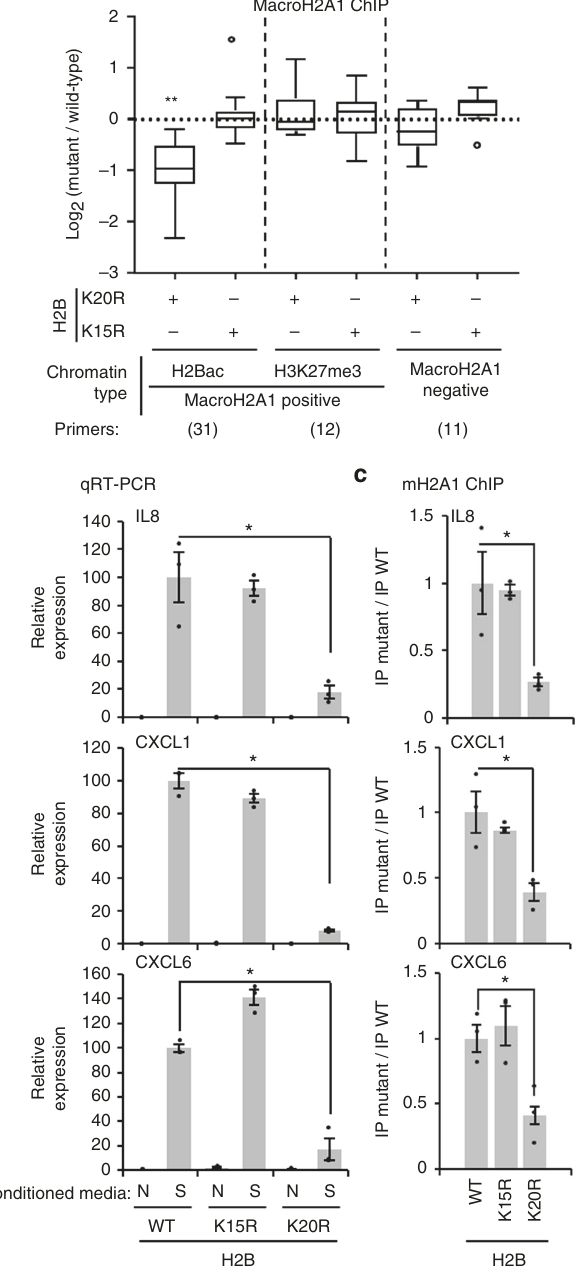
Fig. 5 H2BK20ac promotes macroH2A1 deposition into H2B-acetylated chromatin. a Endogenous macroH2A1 ChIP-qPCR from cells expressing H2B constructs described in Fig. 3b using primers targeting locations within the indicated types of chromatin (regions containing either H3K27me3 or H2B-acetylated chromatin that are associated with macroH2A1 or lack macroH2A1). Data is displayed as a ratio of mutant H2B to wild-type H2B. Center line is the mean and bounds are 95% con fi dence interval of the mean. (* p = 1.6 × 10 − 11 ). b RT-qPCR for the indicated SASP genes from cells described in Fig. 3b that were subjected to paracrine senescence with conditioned media from H-Ras V12 -mediated oncogene induced senescent cells (S) or with cultured media from normal cells (N) as a control. (* p < 0.02). c Endogenous macroH2A1 ChIP-qPCR for SASP genes shown in b . Bars represent the ratio of macroH2A1 association in mutant to wild-type H2B. ( p < 0.03). Error bars, s.e.m., n = 3 independent cell passages, p -values calculated from a two-tailed Student ’ s t